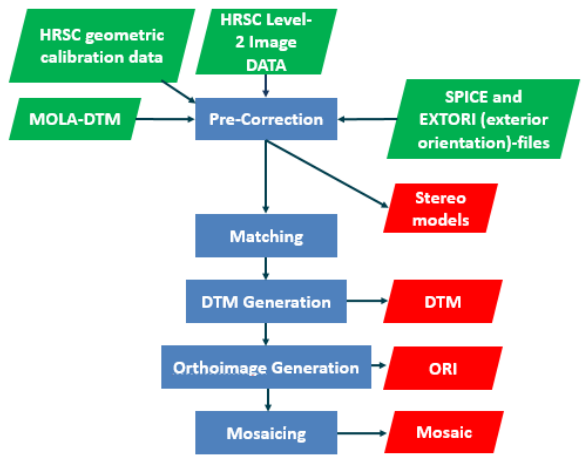
Figure 1. Processing Chain used for Generating DTMs and ORIs by DLR-VICAR (simplified, based on Scholten et al., 2005) Figure 2 Processing Chain used for Generating DTMs and ORIs by DLR-VICAR method modified by Kim & Muller (based on Heipke et al., 2007; Kim and Muller,